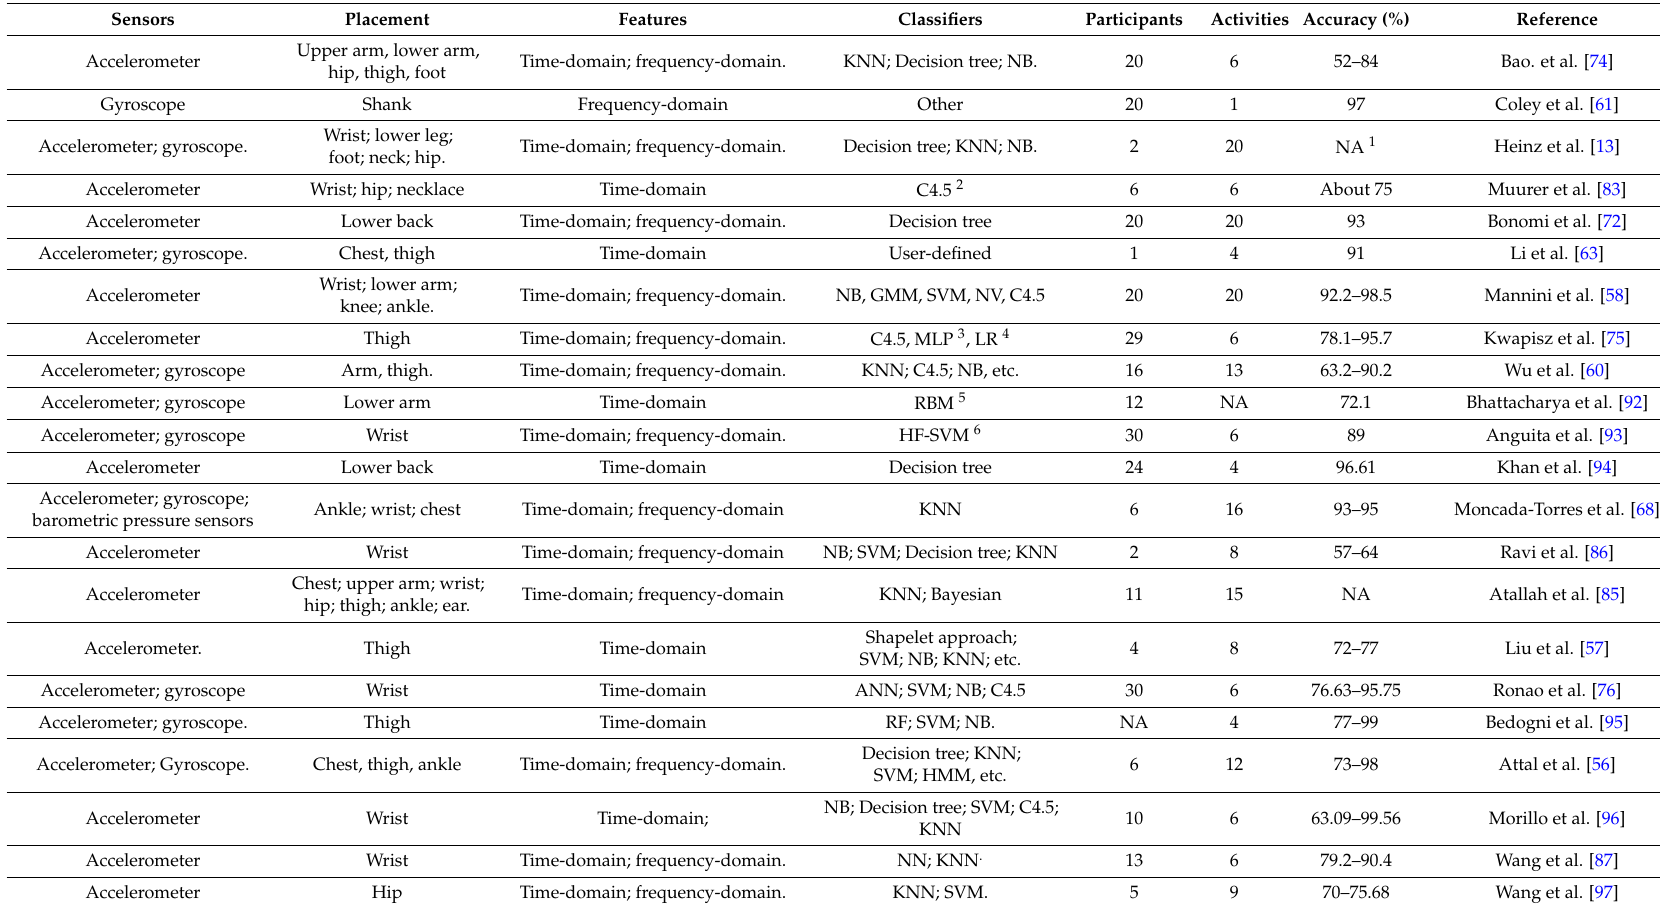
Table 5. State of the art of human activity classification